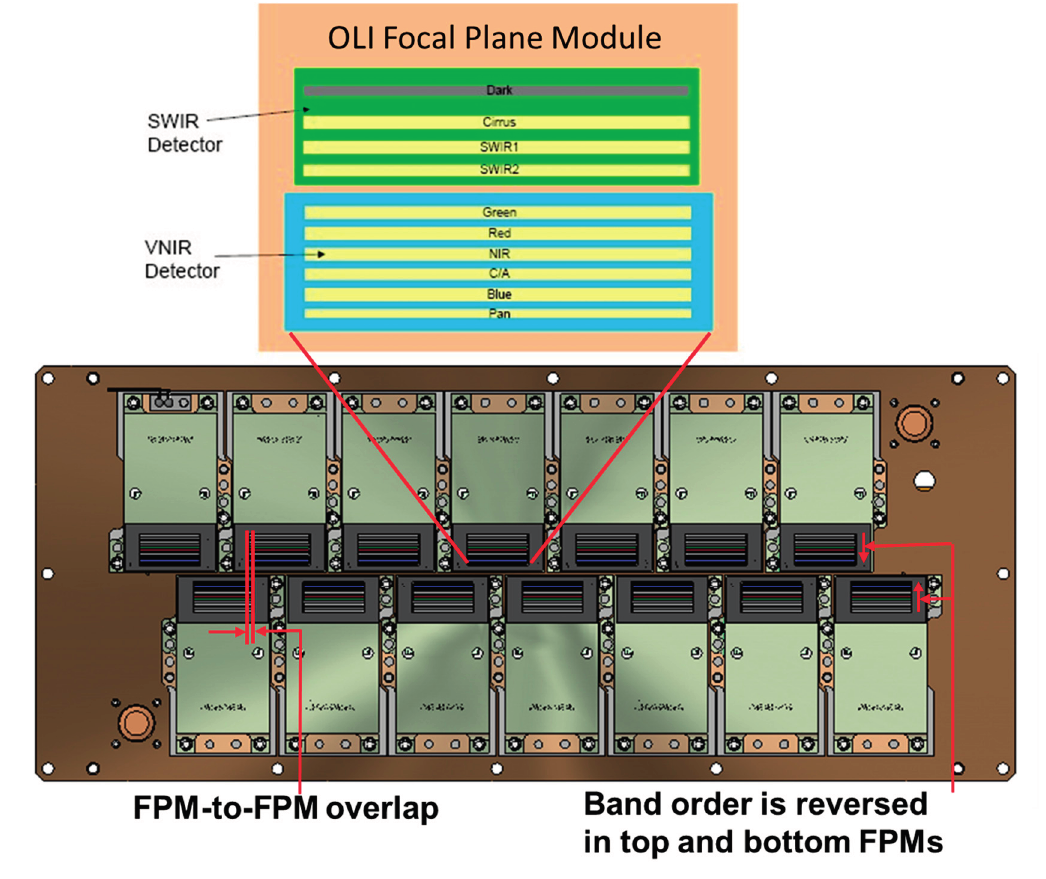
Figure 1. The Operational Land Imager (OLI) focal plane layout showing: top—the arrangement of the visible and near infrared (VNIR) and short-wave infrared (SWIR) spectral bands in the along-track direction; and bottom—the 14 focal plane modules across the OLI field of